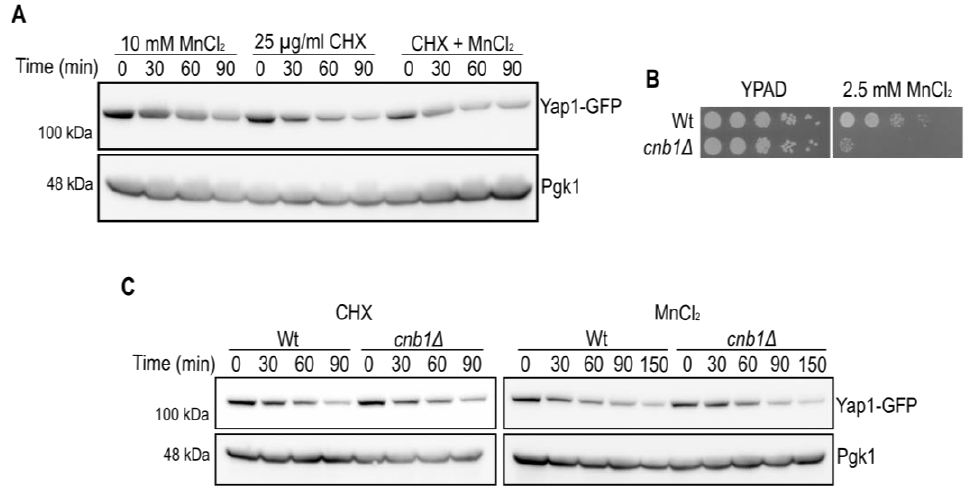
Figure 3. Calcineurin B is not involved in MnCl 2 -driven Yap1 decay. ( A ) Immunoblot of Yap1-GFP protein levels after MnCl 2 and/or CHX addition. The incubation times (min) prior to cell collection are indicated. Pgk1 (3-phosphoglycerate kinase 1) protein levels served as a loading control. ( B ) Growth on MnCl 2 -containing medium. 10-fold dilutions of exponentially growing cells are shown. Strains and MnCl 2 concentrations are indicated. The pictures were taken after 2 days of growth. ( C ) Immunoblot of Yap1-GFP protein levels in Wt and cnb1∆ mutant cells after CHX ( left panel) or MnCl 2 ( right panel) addition. See ( A ) for further description.